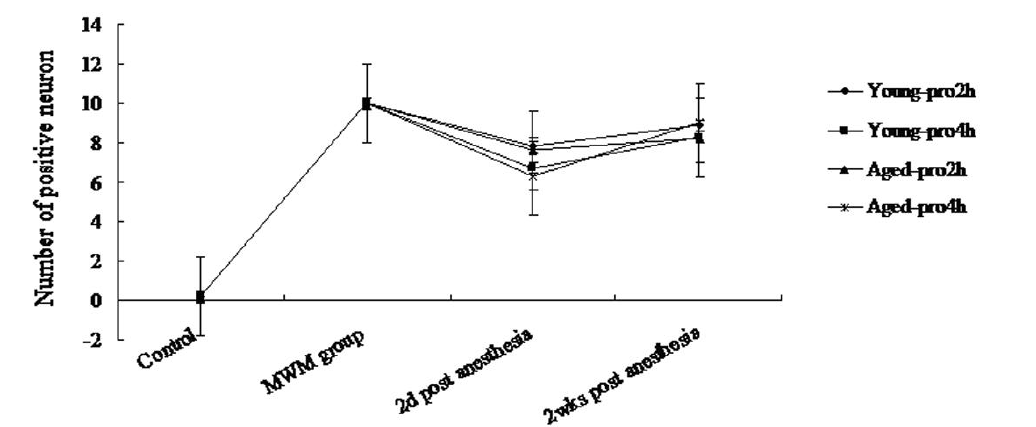
FIGURE 4 - Effect of propofol anesthesia on the expression of c-Fos. Few c-Fos were seen in the hippocampal CA1 area of both young and aged rats. In MWM groups of all rats, number of c-Fos positive neurons in this area was significantly increased (P < 0.05), which was not affected by propofol exposure (P>0.05).